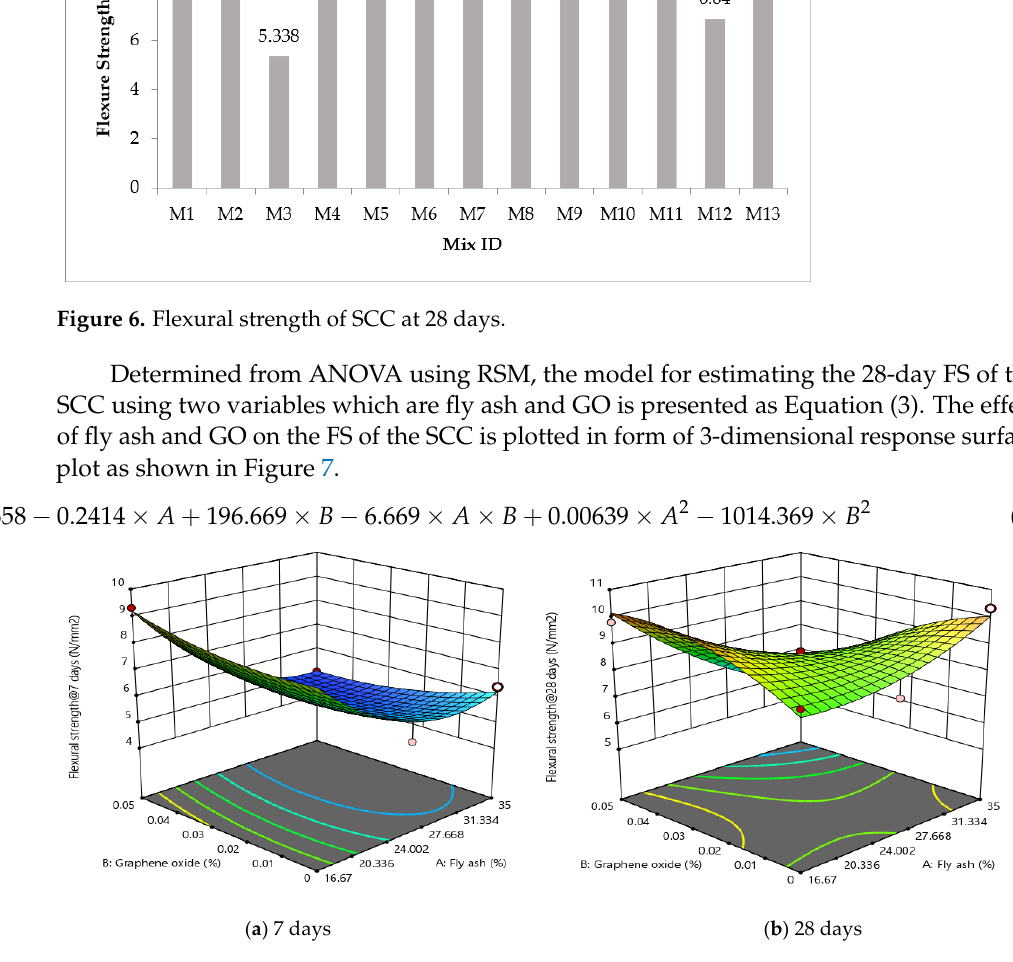
Figure 7. Response surface plots for flexure strength: ( a ) 7 days, ( b ) 28 days.